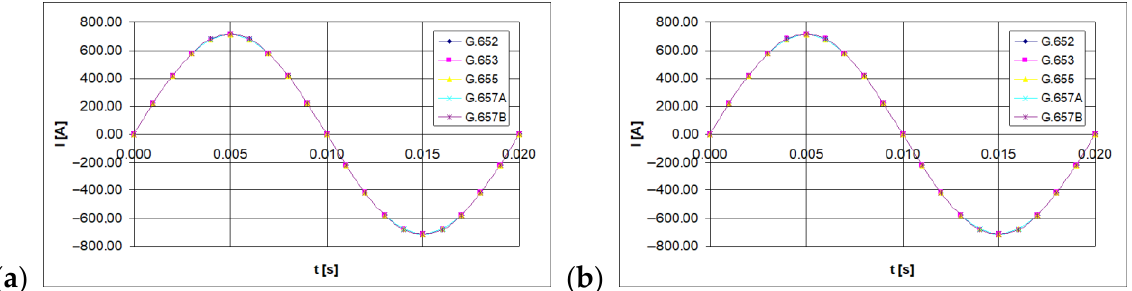
Figure 5. The time waveform measured with forced RMS current value of 500 A, depending on the single mode telecommu- nications fiber standard [own results]: ( a ) for 40-turns measuring coil and ( b ) for 80-turns measuring coil.